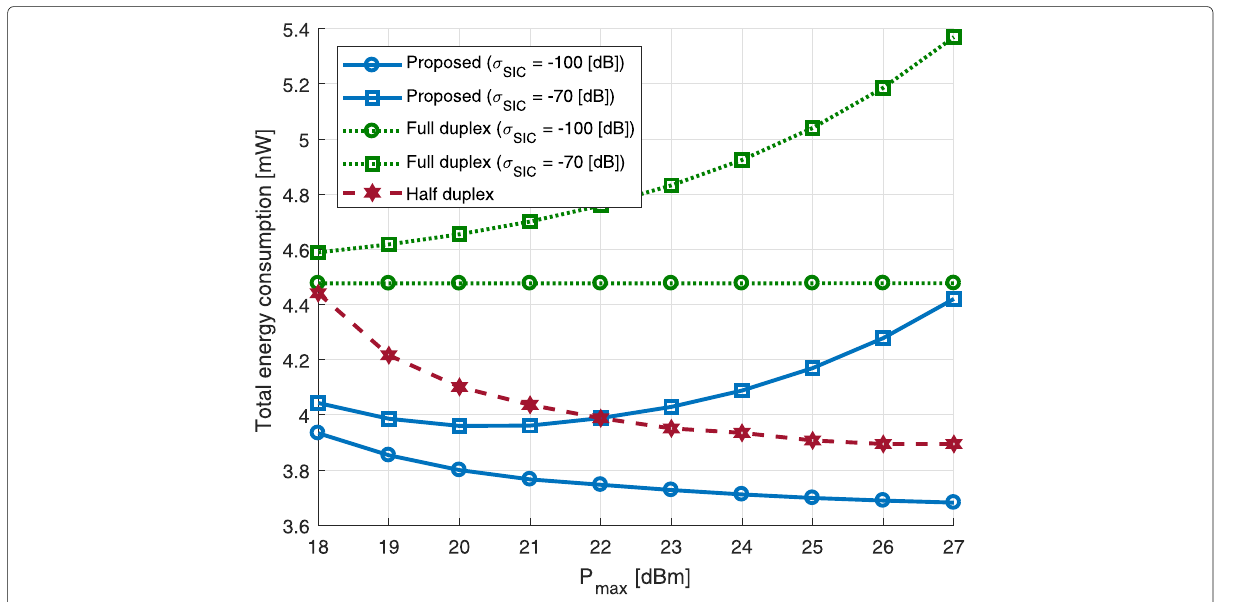
= − 4[dB], and D = 10[m] SI